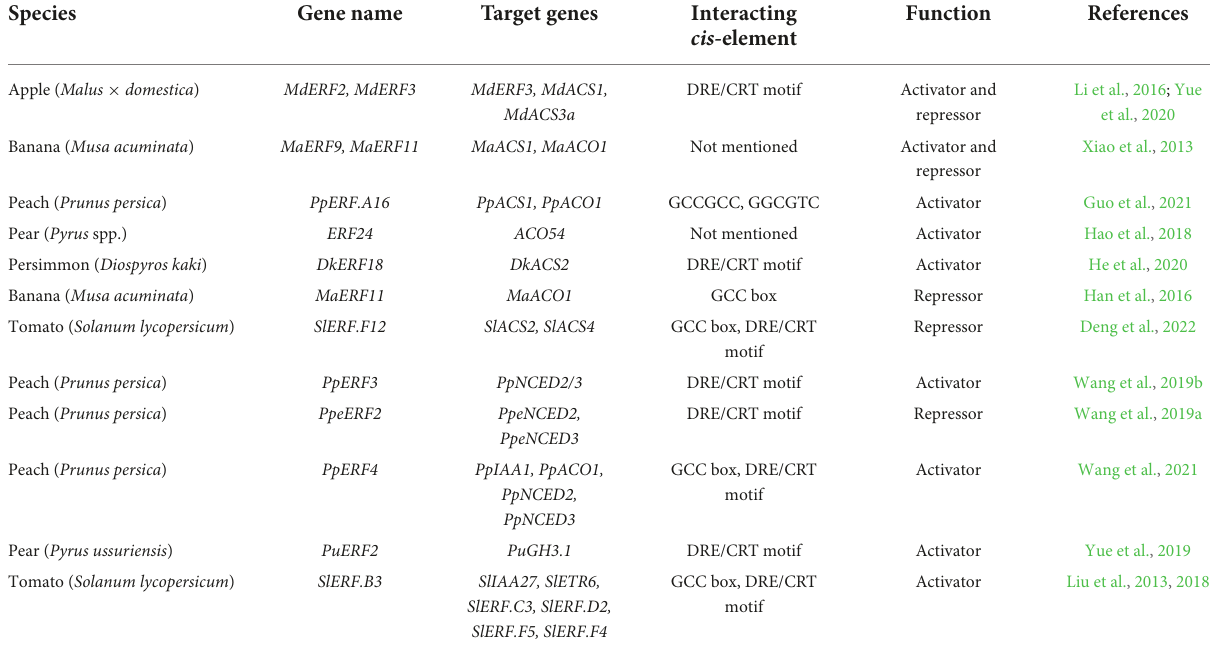
TABLE 2 AP2/ERF regulation of hormone